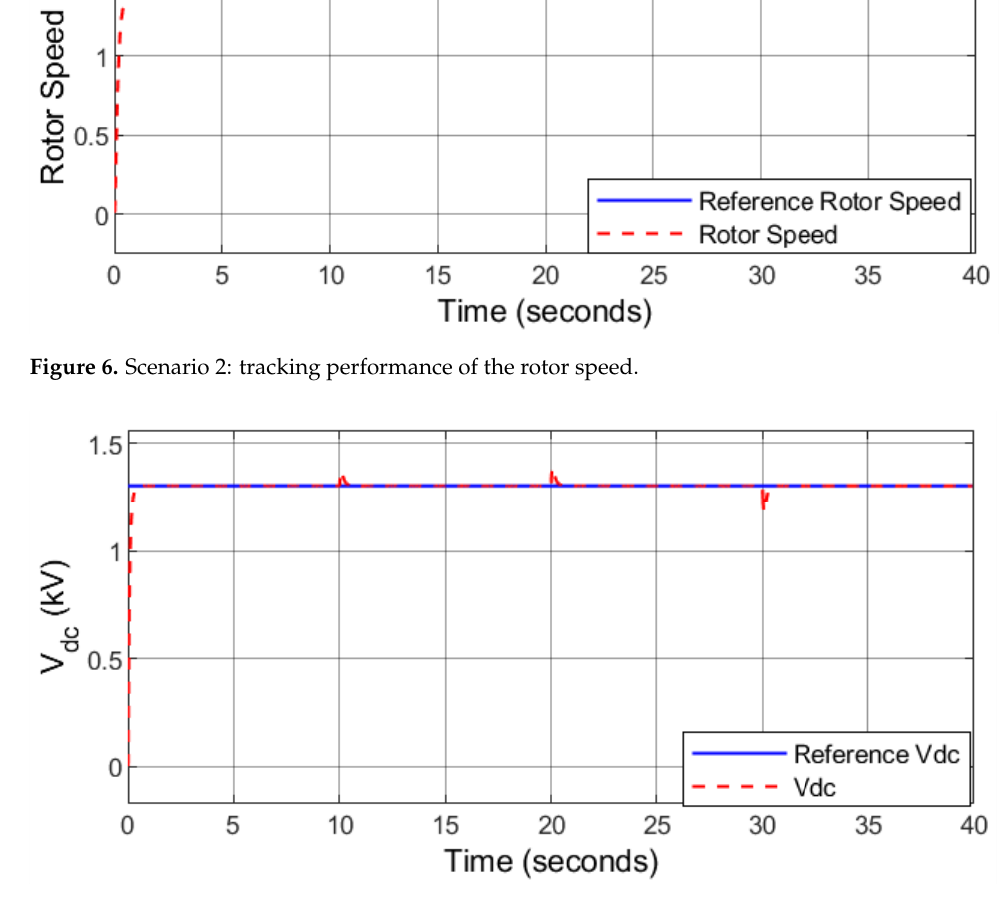
Figure 7. Scenario 2: tracking performance of the DC-link